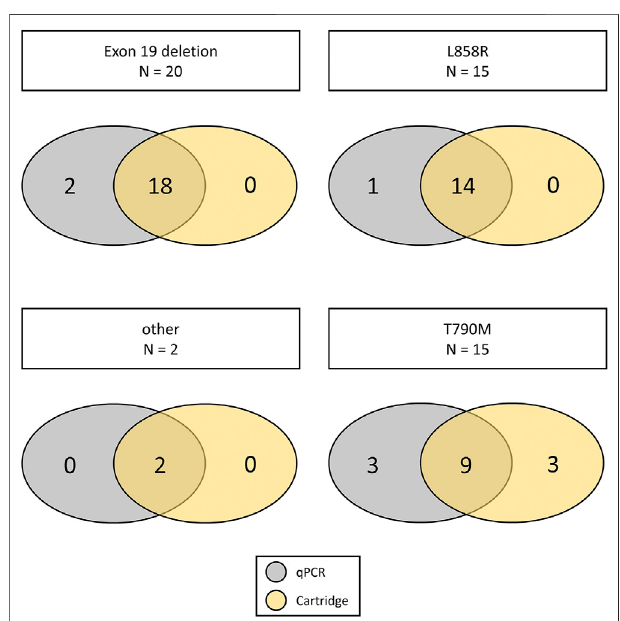
FIGURE 2 | Overview on the mutations detected by the different systems. Each row represents one of the systems used for the detection of EGFR mutations and each case is represented by one